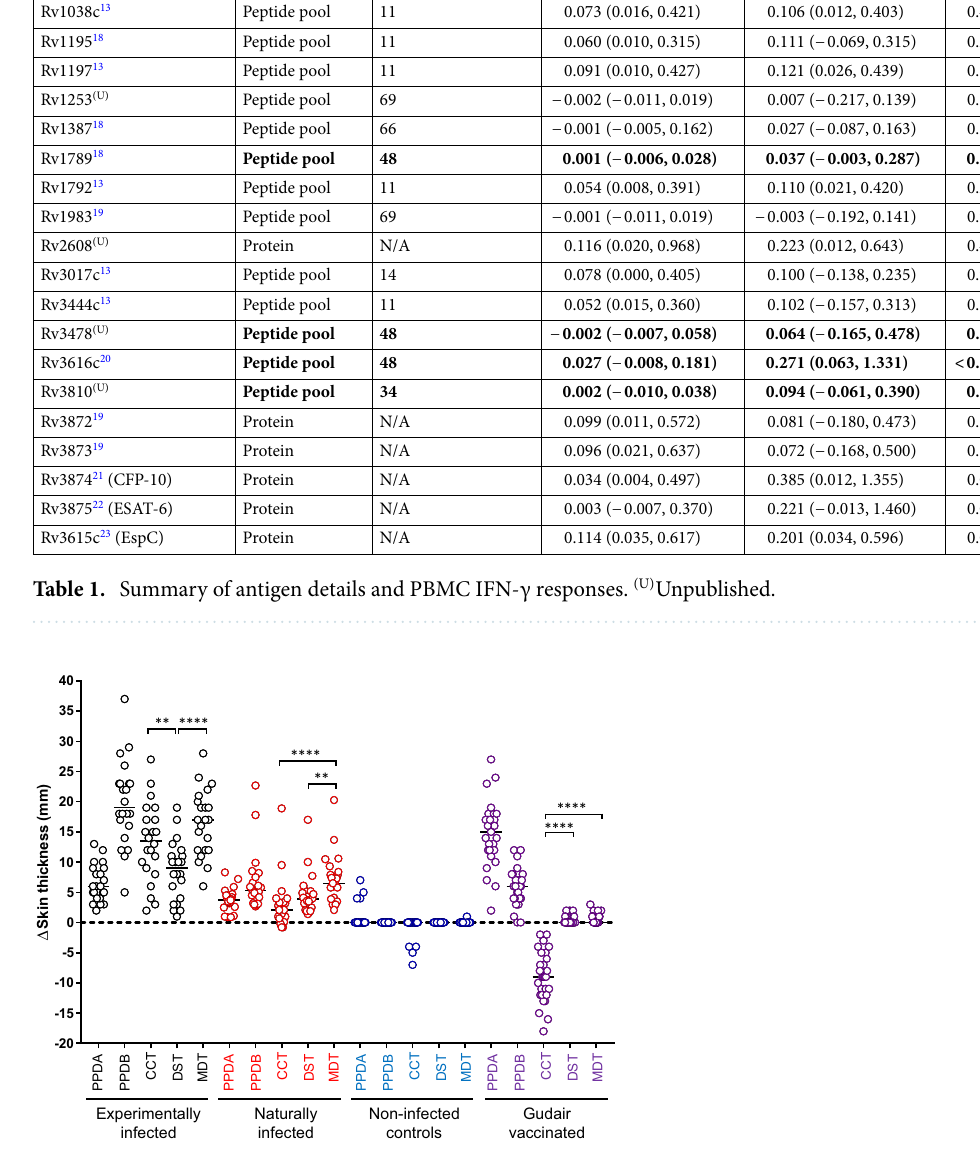
Figure 1. Comparison of MDT and DST induced skin test reactions in cattle. Skin test responses to PPDs, DST and MDT reagents were measured at 72 h after injection in cattle experimentally infected with M. bovis ( n = 22), cattle naturally infected with M. bovis (n = 21), naive controls ( n = 30) and Gudair vaccinates (n = 29). Results are expressed as the difference in skin thickness between the pre- and post-skin test readings. Each symbol represents an individual animal while horizontal lines represent group medians. ** p < 0.01, **** p < 0.0001, Friedman test with Dunn’s multiple comparisons